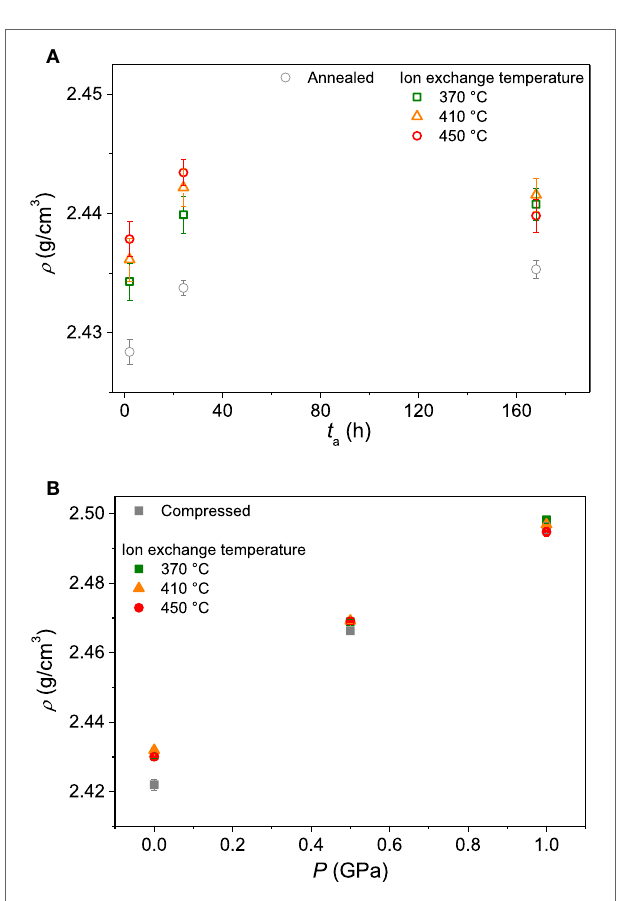
FigUre 4 | Depth of the ion exchanged layer (DOl) as function of the change in density as a result of ion exchange ( Δρ ) for both the as-prepared, thermally annealed, and compressed samples ion exchanged at three different temperatures (370, 410, and 450°c) . An approximate linear dependence is found for each ion exchange temperature. Dashed lines are guides for the eye.